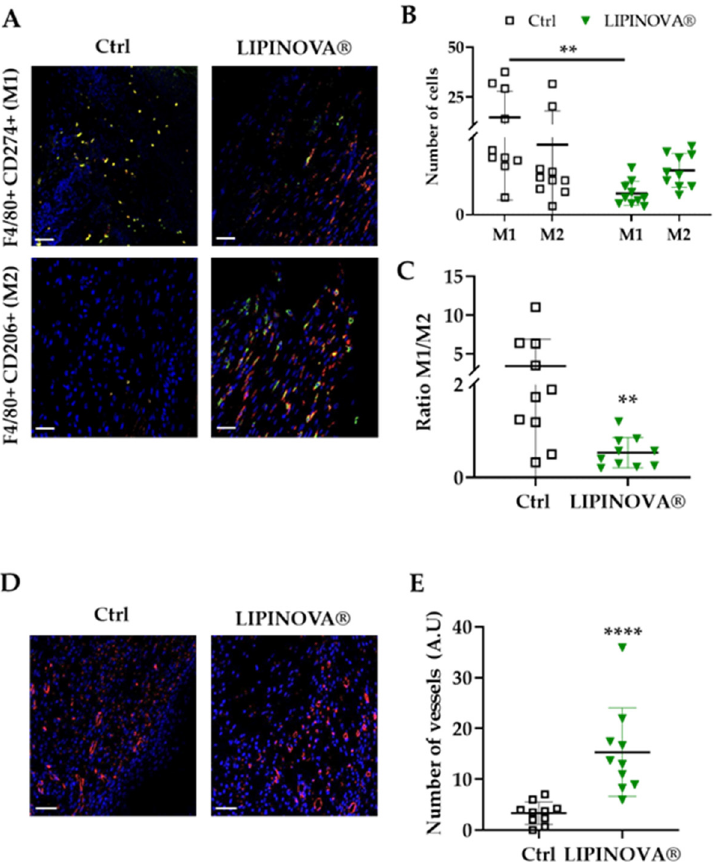
Figure 5. LIPINOVA ® promotes the modulation of M φ 1/M φ 2 phenotype and increases angiogene- sis on cutaneous wounds in db/db mice. ( A ) Representative immunofluorescence images of wound sections stained with specific M φ 1 and M φ 2 antibodies: F4/80+ (red), CD274+ (green), and CD206+ (green). Nuclei are stained with DAPI (blue). ( B ) Quantification of the M1/M2 macrophage profile ratio. ( C ) Number of cells stained with antibodies that recognize M φ 1 and M φ 2 in control and LIPINOVA ® groups. ( D ) Representative images of wound sections stained with a caveolin antibody. ( E ) Quantification of the number of vessels in the wound area; scale bar = 50 µ m. Data are represented as the mean ± SD, ** p < 0.01, **** p < 0.0001. n = 10 animals per group.